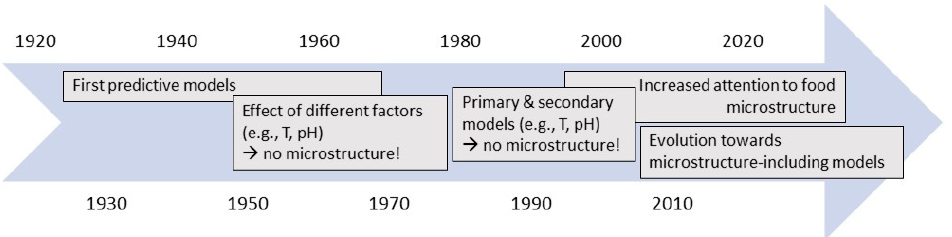
Figure 2. Timeline depicting the evolution on the inclusion of food microstructure into predictive models over the years.